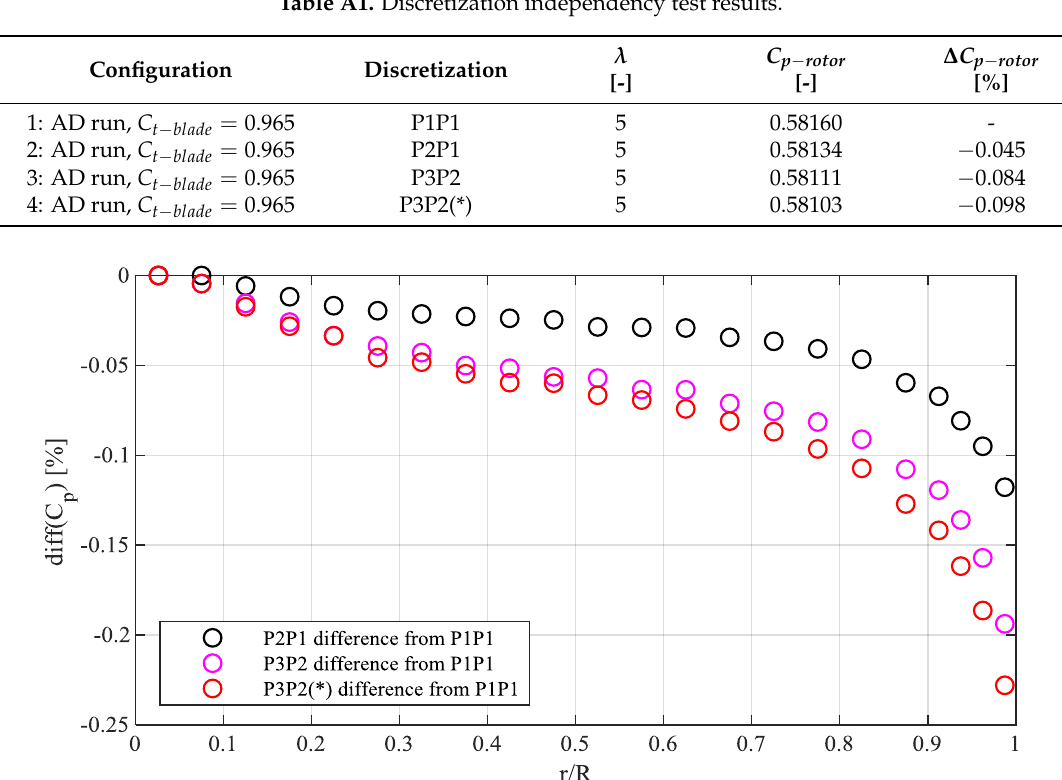
Figure A1. Relative difference in C p distribution for different discretizations.